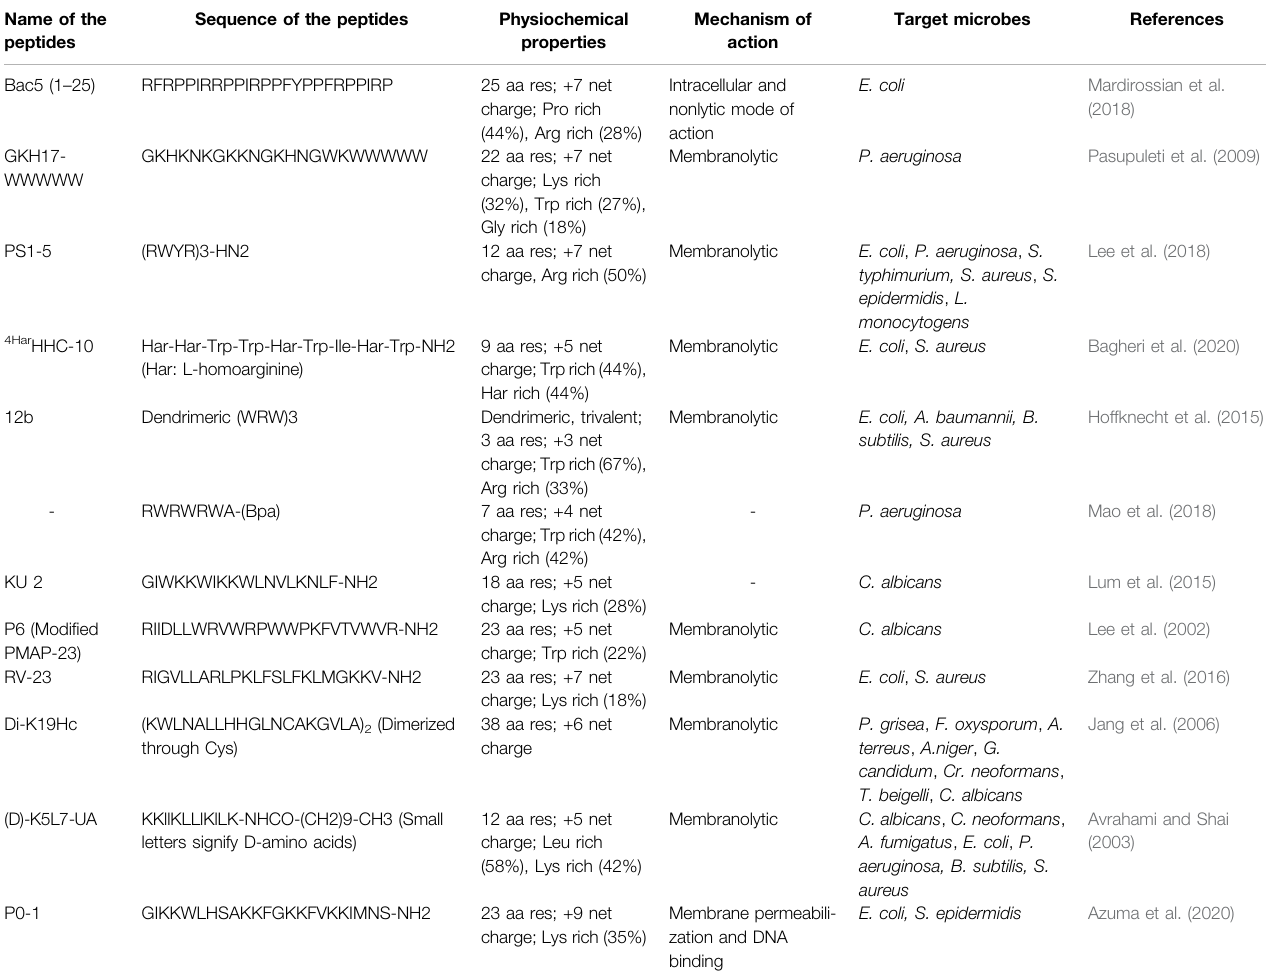
TABLE 2 | ( Continued ) Synthetic antimicrobial peptides (aa (cid:1) amino acid, res (cid:1)